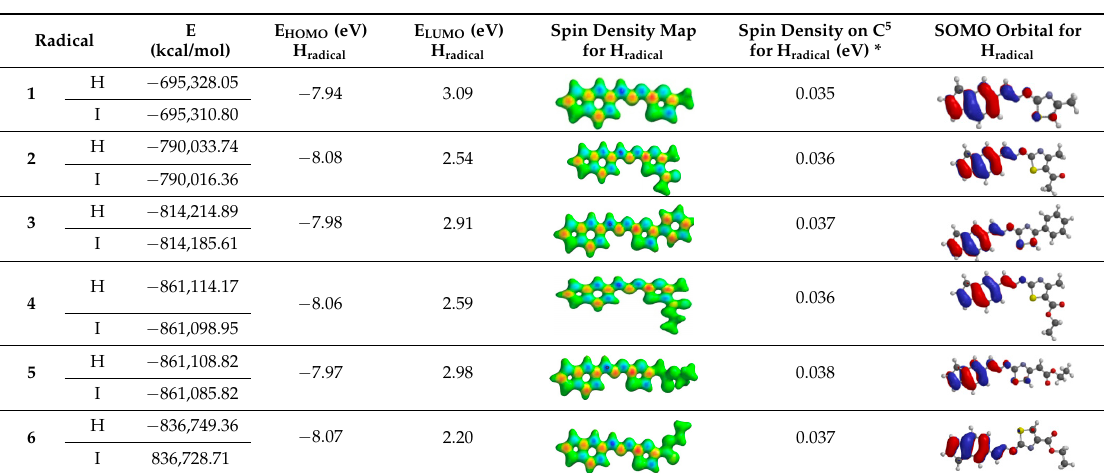
Table 3. The quantum molecular parameter and spin density distribution for H type radicals generated from indolyl-hydrazinylthiazoles 1 – 6